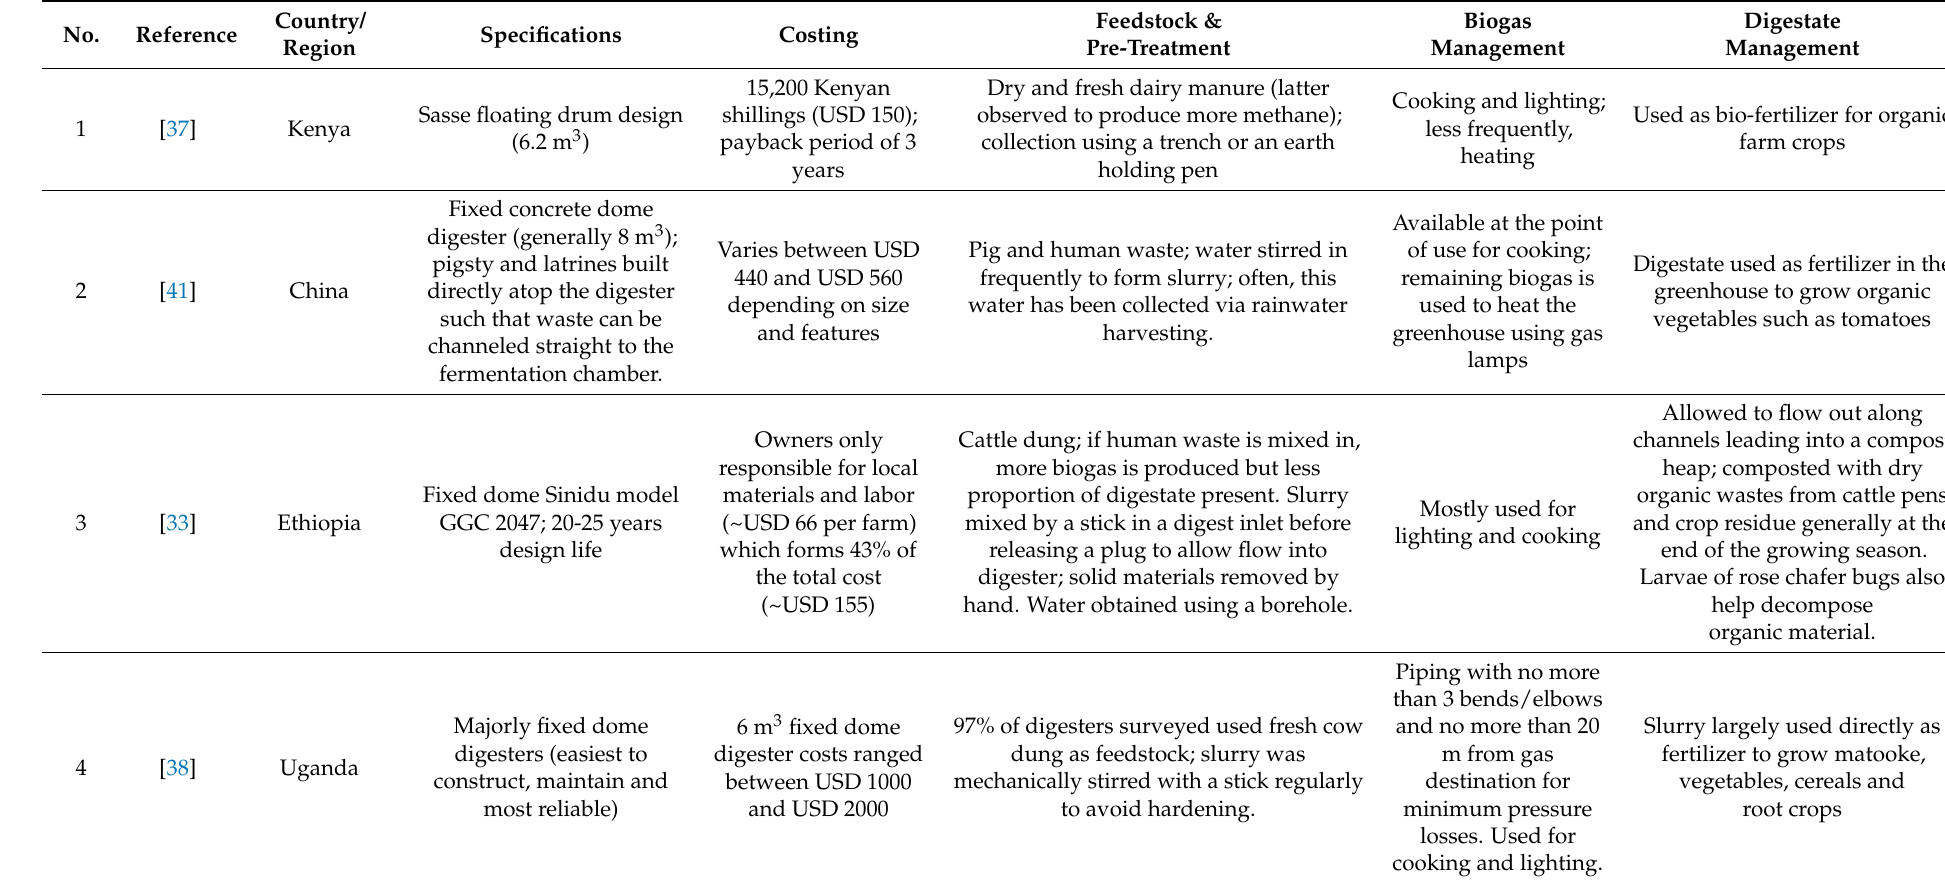
Table 2. Data extracted from case studies for